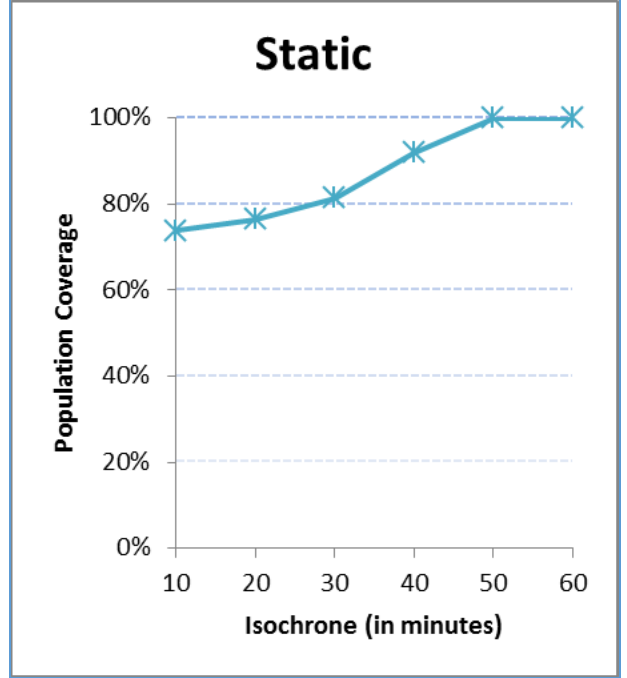
Figure 4. Static coverage of